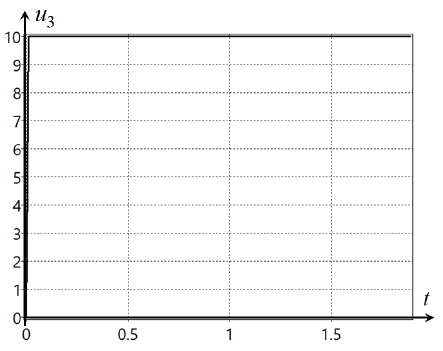
Figure A9. Plot of optimal values of control component u 3